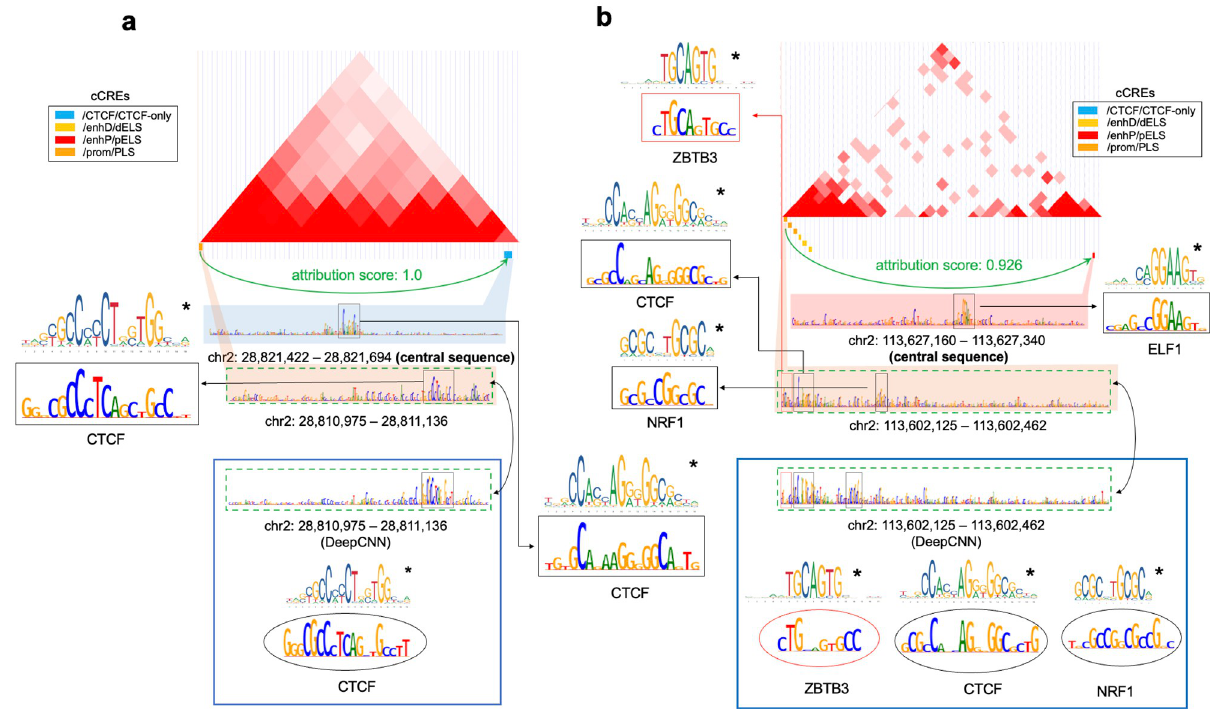
Fig 5. Visualization of attribution scores on chromatin contacts, central sequences, and neighbor sequences. The hESC Micro-C contact map is visualized in the UCSC genome browser [28]. The green arrow represents a Mirco-C contact pointing to the central sequence side. The attribution scores of the Micro-C contacts for CTCF are provided. The candidate cis-regulatory elements (cCREs) within both anchors of the contact are shown as small colored rectangles, which are attributed for TFs binding on the central sequence. High attribution score regions are plotted in the black rectangles. The binding motifs from JASPAR are marked with ? . As a comparison, the attribution scores of cCREs on the neighbor sequence sides contributing to TFs binding on the neighbor sequences are computed using the baseline DeepCNN, which are shown in the large blue blocks. The corresponding high attribution score regions are plotted in ovals. (a) The high attribution score regions on both the two cCREs match known CTCF motifs from JASPAR. (b) The regions within the red rectangles match binding motifs of TFs not included in our collected data. The attribution scores of the neighbor sequence’s cCREs computed by ECHO identify ZBTB3 which was not identified by DeepCNN. The attribution scores from ECHO detected NRF1’s motif, which is more proximate than the one identified by DeepCNN.